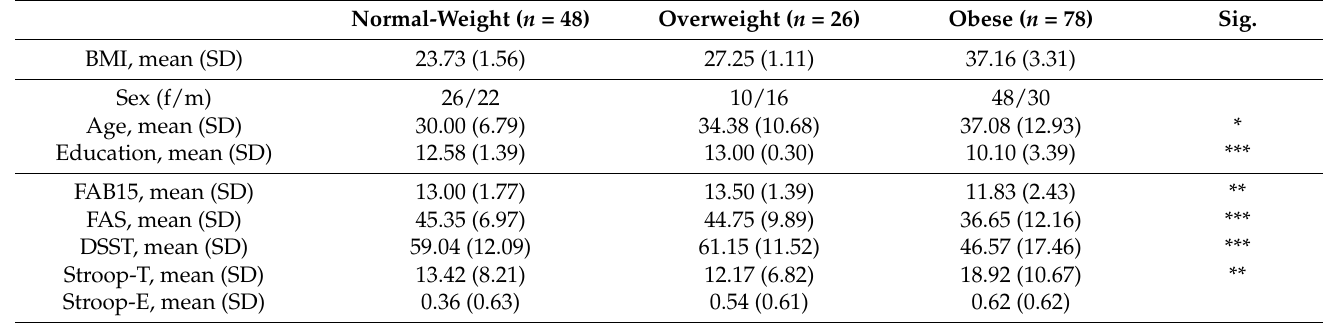
Table 1. Sample characteristics and raw performance on executive tasks for each group.